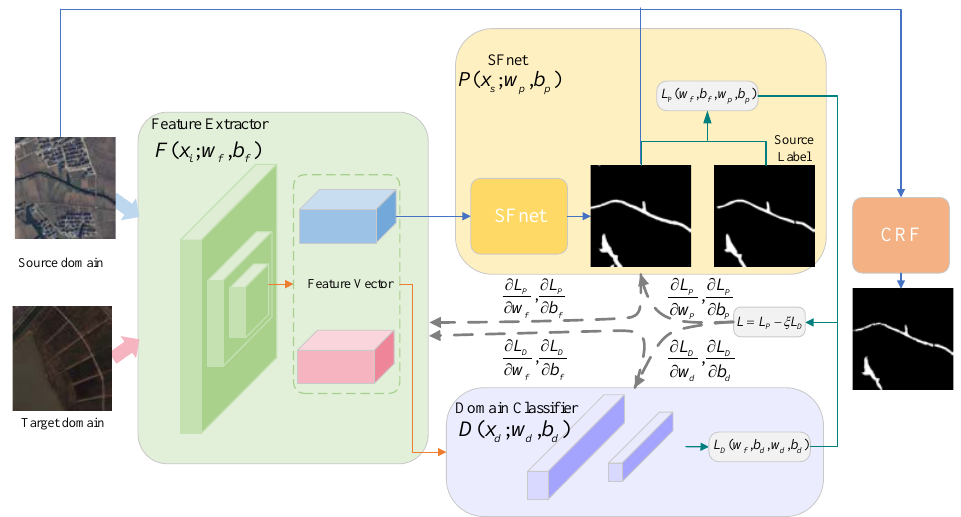
Figure 1. The flow chart of the SFnet-DA.